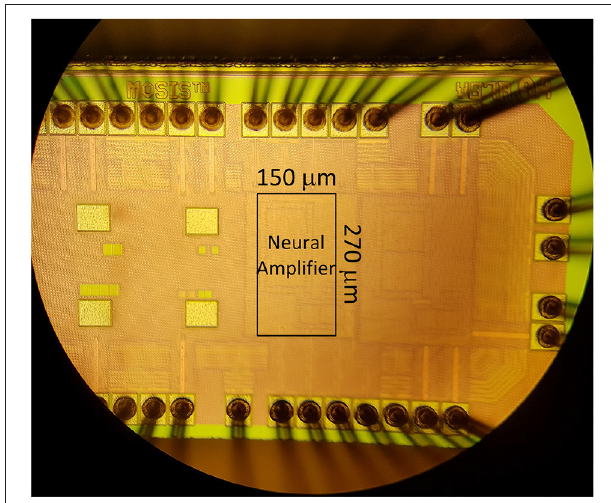
FIGURE 17 | Micrograph of chip containing the neural amplifier with 270 µ m 150 µ m die area. ×